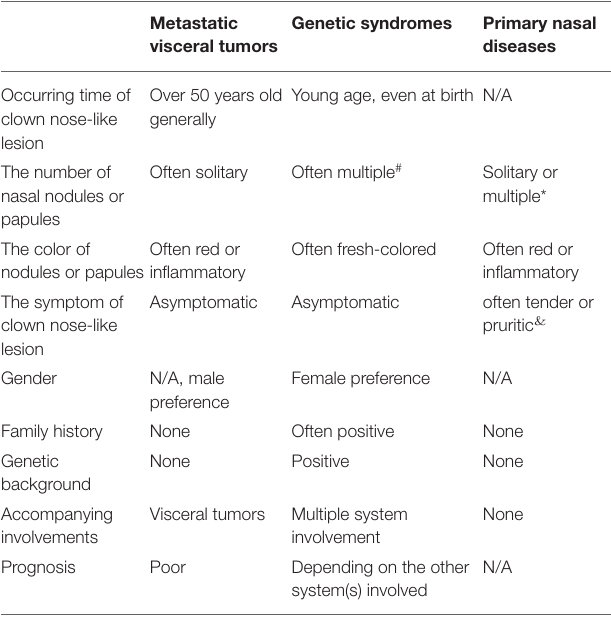
TABLE 5 | Identification points of clown nose-like